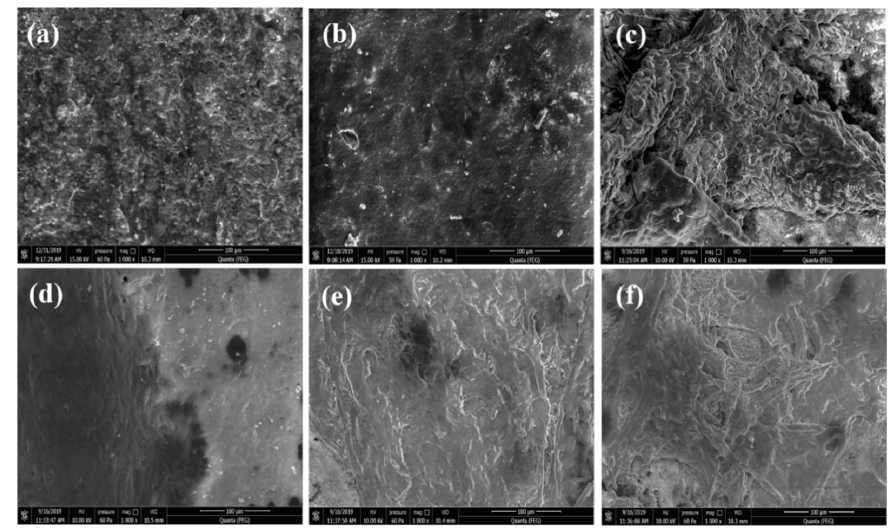
Figure 9. Morphology of HAp samples seeded with MG-63 cells. ( a ) HAp1200, ( b ) HAp1250, and ( c ) HAp1300 samples after 5 days; ( d ) HAp1200, ( e ) HAp1250, and ( f ) HAp1300 samples after 7 days.